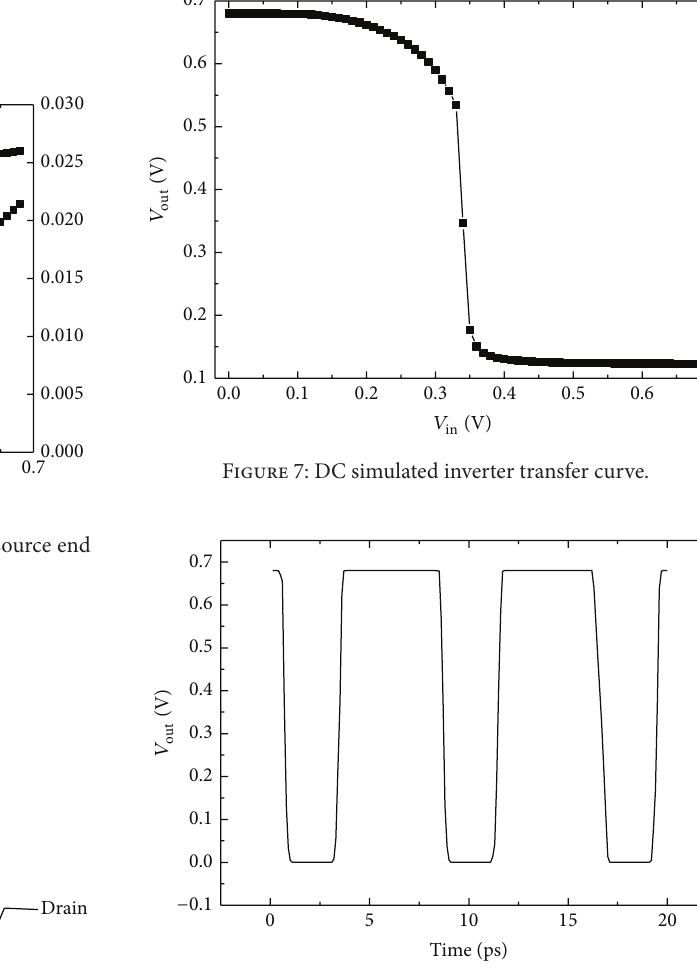
Figure 3: Simulated drain current as a function of gate voltage at low and high drain biases.